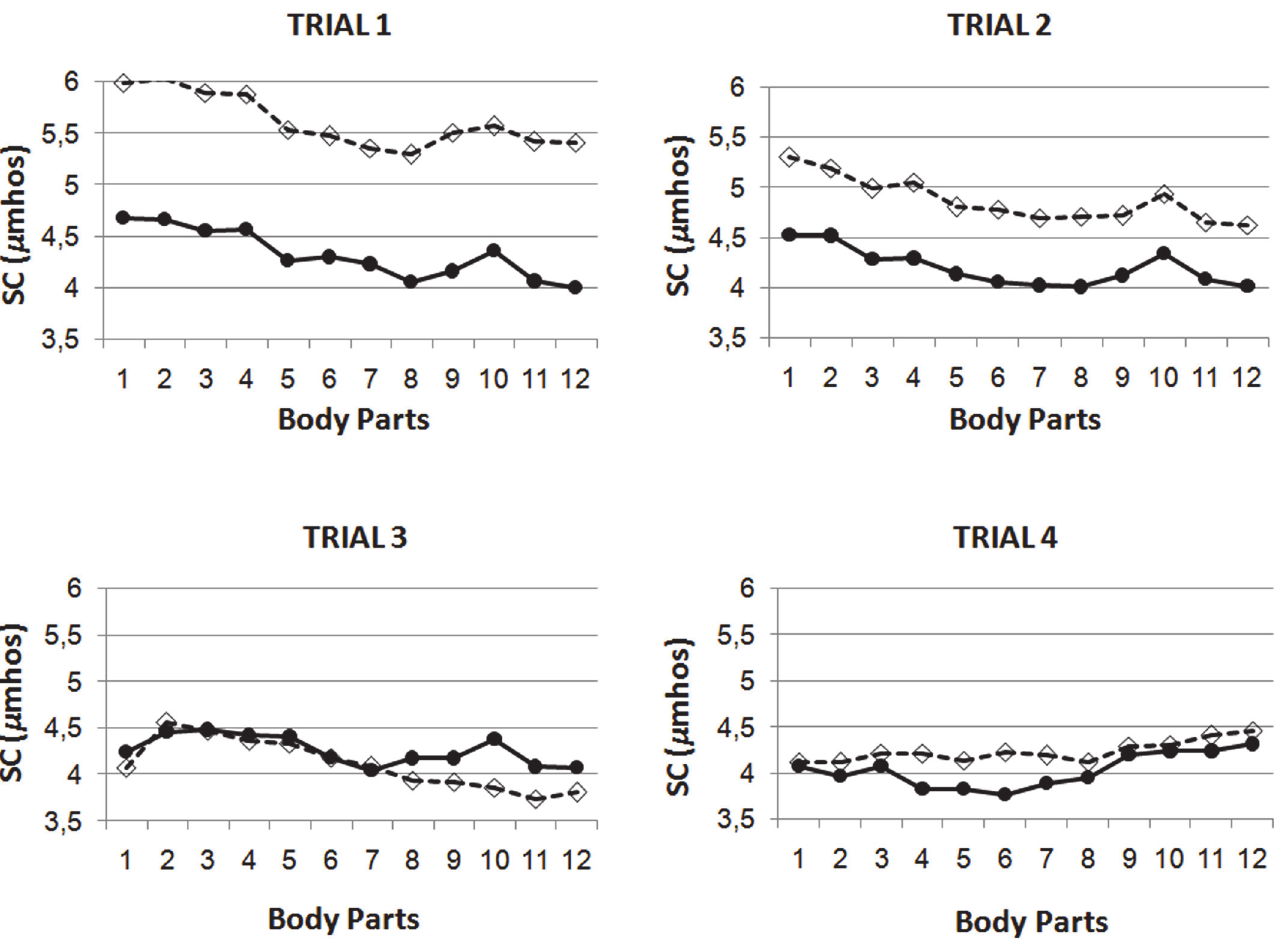
Fig 2. Skin conductance (SC) responses. Peak SC values along the view of the 12 body parts during the four exposure trials as a function of group. (same body parts and symbols as in Fig 1).